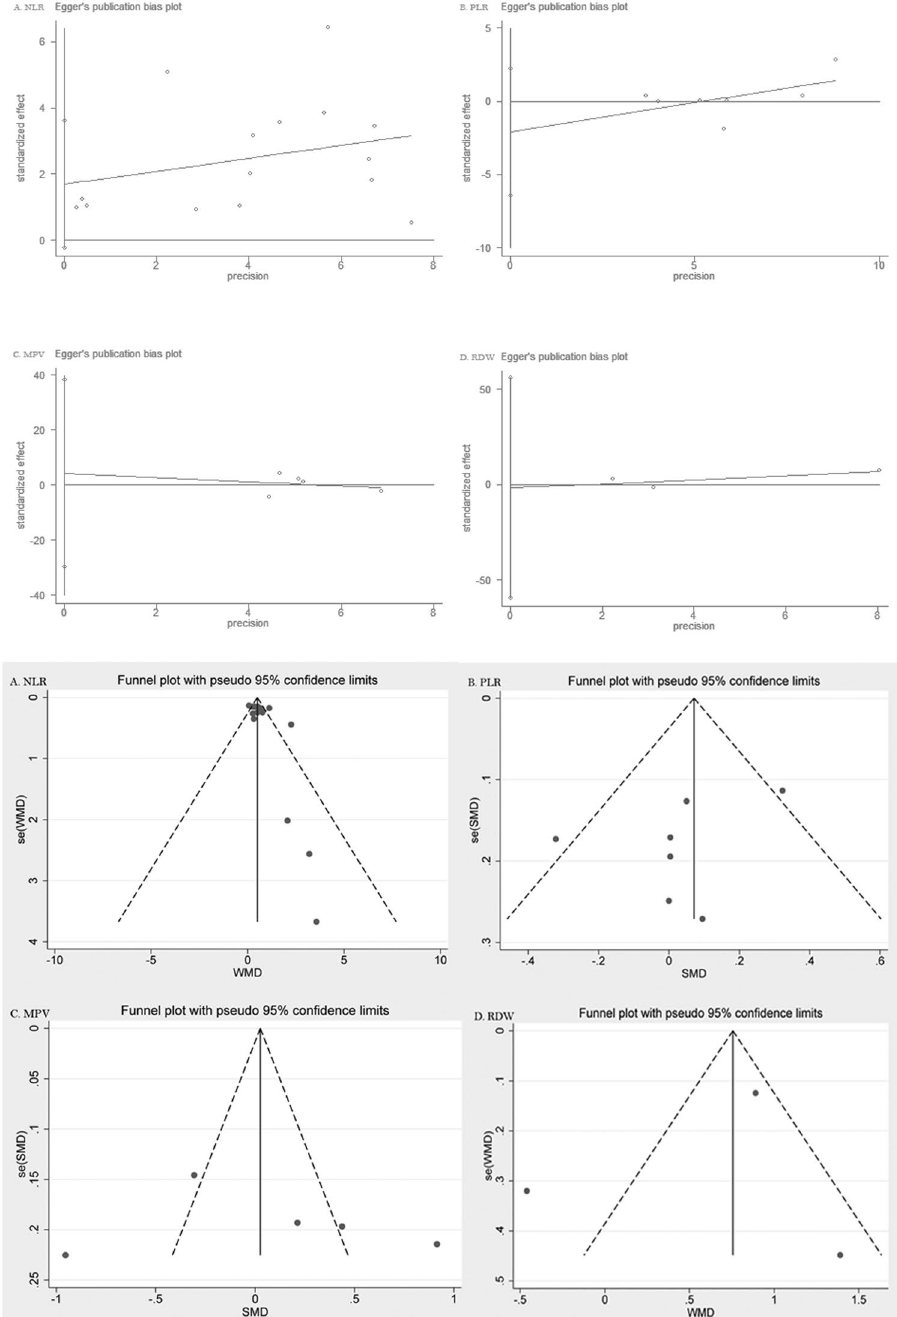
Figure 7. Funnel plot and Egger’s test evaluating the publication bias of studies. NLR and ARDs ( A ), PLR and ARDs ( B ), MPV and ARDs ( C ), and RDW and ARDs ( D